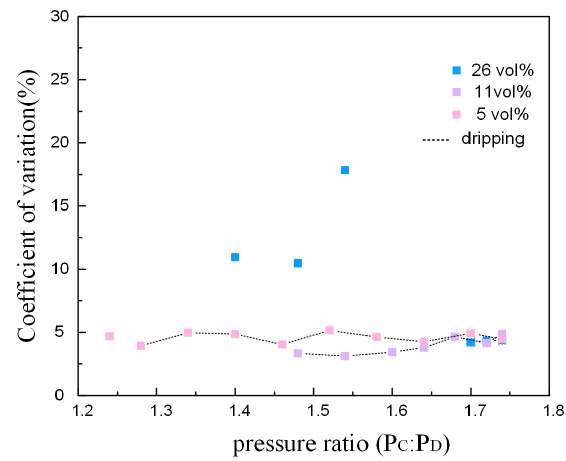
Figure 8. ( a ) The corresponding pressure ratio of transition from jetting to dripping mode on the basis of the surfactant concentration. ( b ) ETPTA droplet generation frequency.